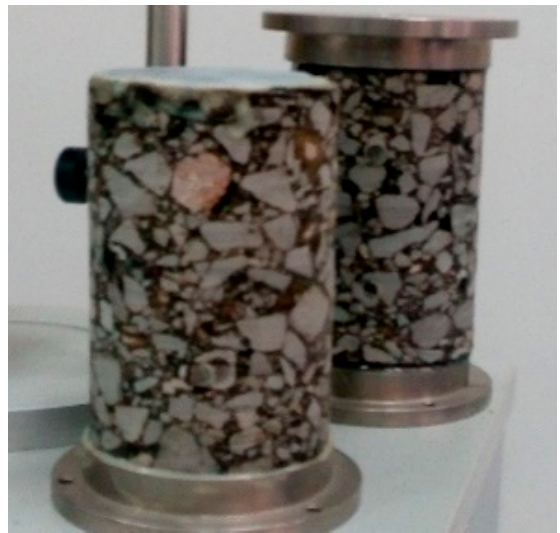
Figure 1. SPT equipment.